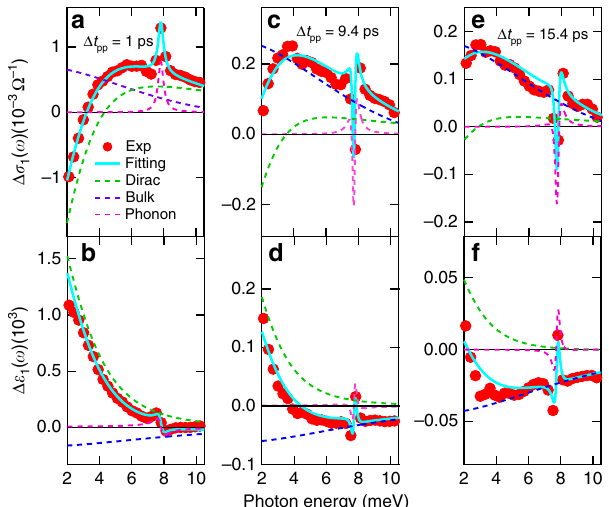
Fig. 4 Theoretical fi tting of the pump-induced THz spectra. a , b The fi tting of Δ σ 1 ( ω ) and Δ ε 1 ( ω ) for 248 meV (5 μ m) photoexcitation with fl uence 12 μ J cm − 2 at T = 5 K and pump-probe delay Δ t pp = 1 ps. The experimental results (red dots) are fi tted very well by the THz model from Eq. 1 (cyan lines), which consists of three individual components, i.e., the Dirac surface state (green-dashed lines), bulk state (blue-dashed lines), and optical phonon mode (pink-dashed lines). The fi tting results for c , d Δ t pp = 9.4 ps and e , f Δ t pp = 15.4 ps are plotted in the same manner as a ,